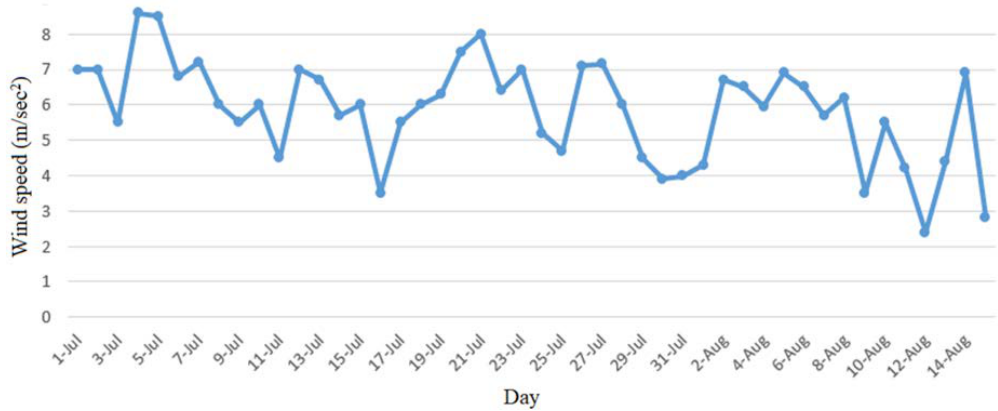
Figure 13. Measured wind speed at the site under study (Assiut University, Egypt) at the maximum solar radiation per day.